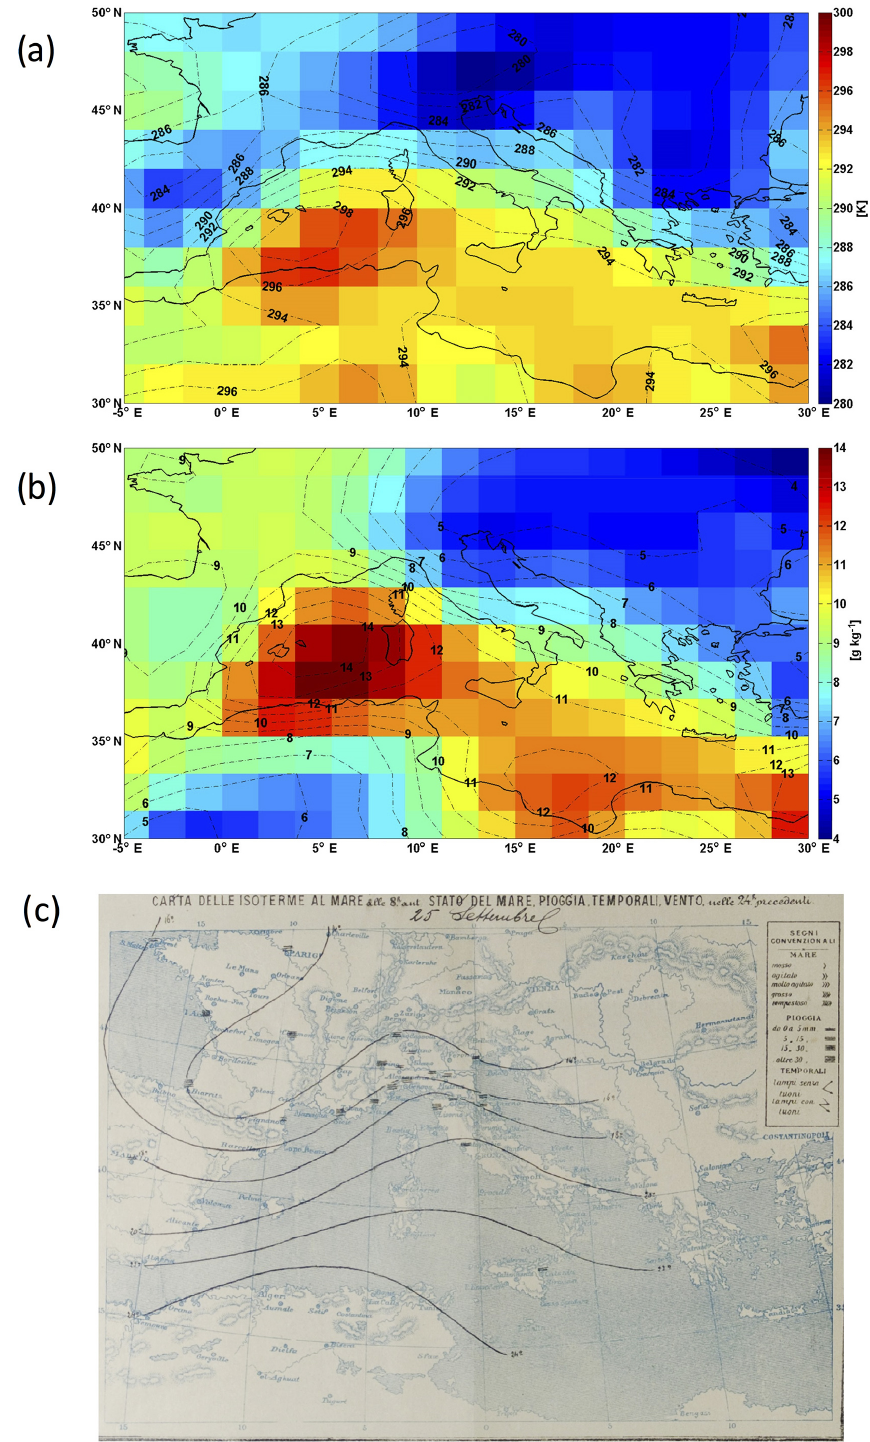
Figure 4. Panel (a) shows 2m temperature and panel (b) shows 2m specific humidity on 25 September 1915 (06:00UTC) over the study region (20th Century Reanalysis mean fields over the 56 ensemble members). Panel (c) shows surface temperature isotherms on 25 Septem- ber 1915 (07:00UTC), as provided by the Italian Royal Meteorological